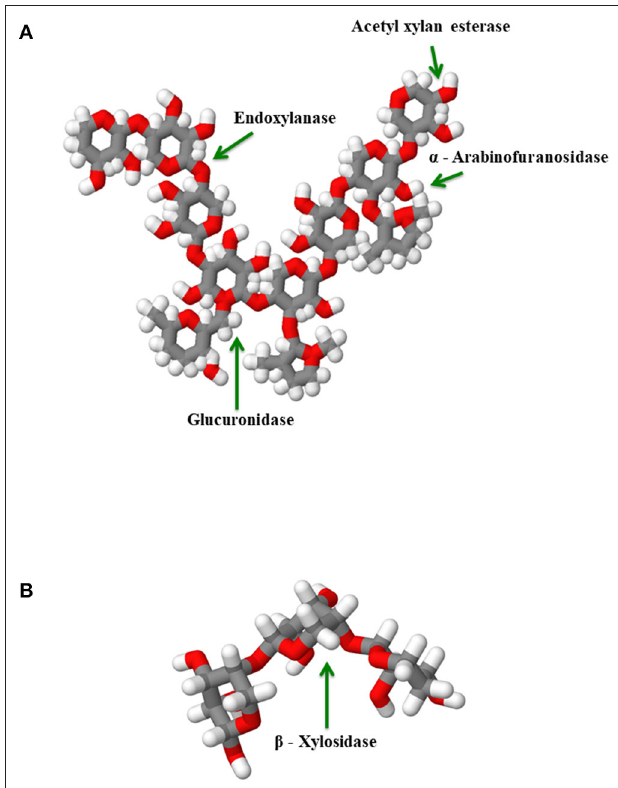
FIGURE 5 | Degradation of xylan polyssacharide and xylooligosaccharide to produce α -arabinofuranose, α -glucuronic acids among other acetyl groups ( Wong et al., 1988): (A) Xylan degradation by xylanolitic enzymes to produce α -arabinofuranose and α -glucuronic acid, (B) β -xylosidase enzyme hydrolytically degrading a